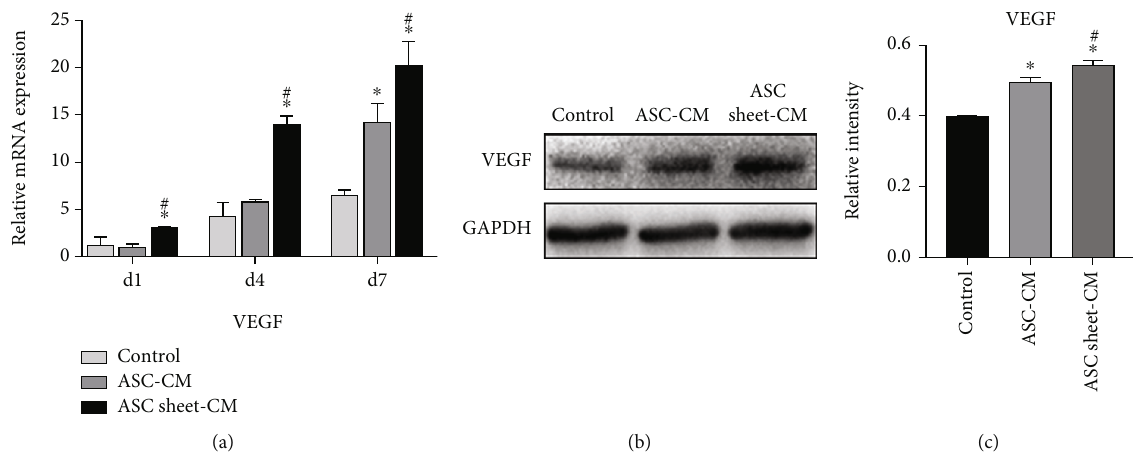
Figure 8: The e ff ects of ASC-CM and ASC sheet-CM on the expression of VEGF in ECs (a) PCR analysis of the mRNA levels of VEGF in ECs on days 1, 4, and 7. (b) Western blotting analysis of protein levels of VEGF in ECs on day 7. (c) The gray values of the protein bands which were measured by the ImageJ software. ∗ p < 0 : 05 , versus the control group; # p < 0 : 05 , versus the ASC-CM group.